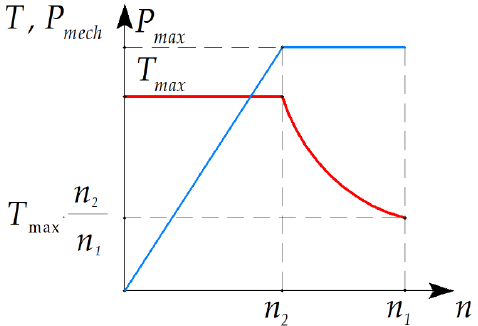
Figure 5. The required torque and mechanical power of the generator as a function of